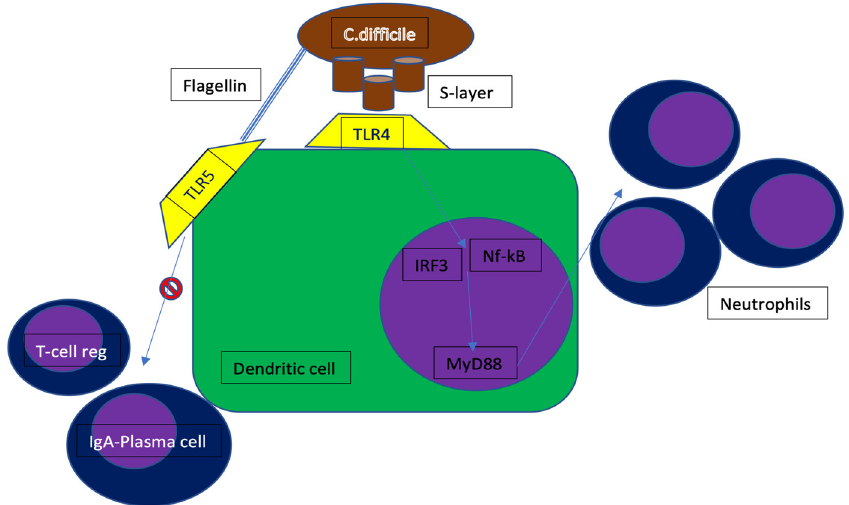
Figure 2. C. difficile mechanism of immune-escape. TLR4 = toll-like receptor 4; TLR5 = toll-like receptor 5; IRF3 = interferon regulatory factor 3; MyD88 = myeloid differentiation factor 88; Nf-kB = nuclear factor-kB.